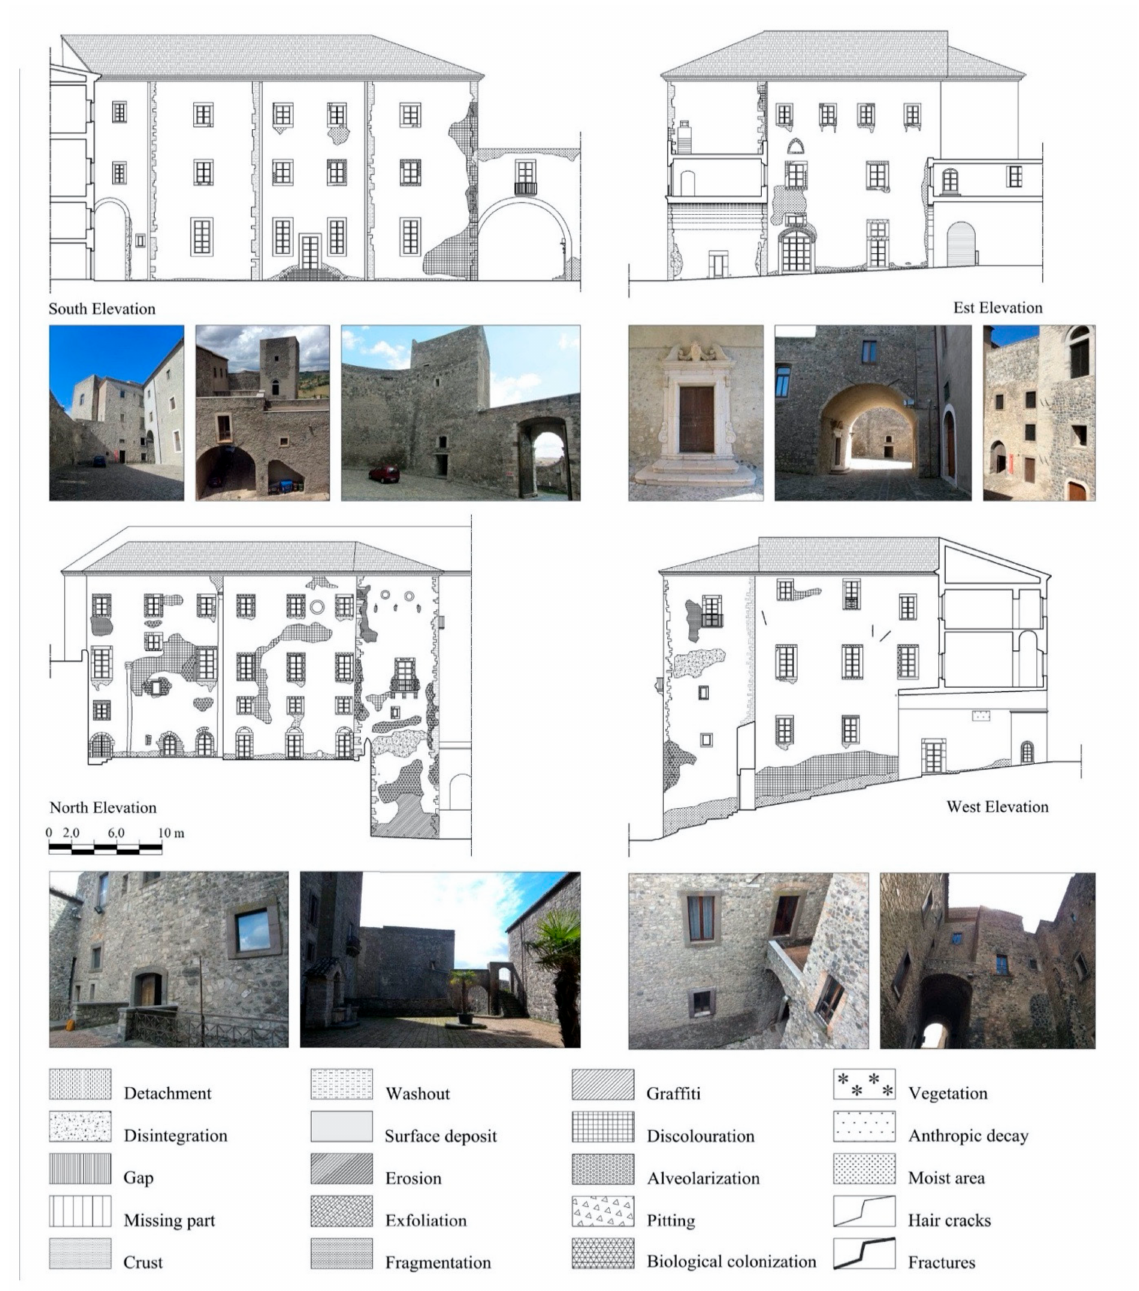
Figure 13. Decay and cracks survey of the east elevation and the part of the north elevation with the greatest signs of